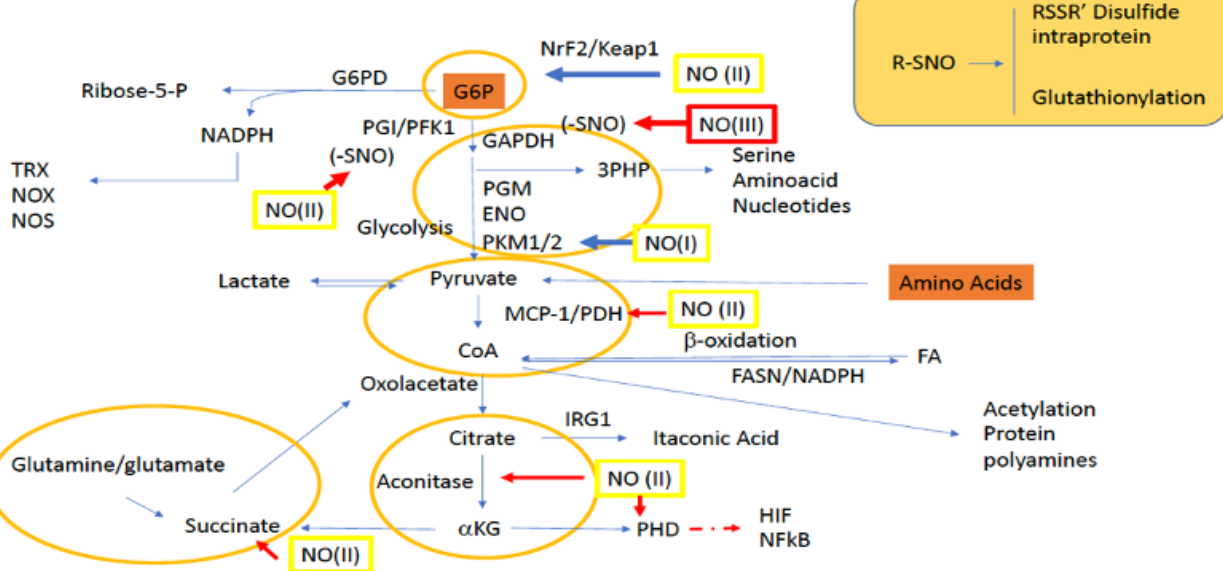
Figure 2. Sites for NO activity along glycolysis, the PPP, and the TCA. Green boxes/(II) represent intermediate levels of NO (nitrosative signaling) and red boxes/(III) indicate high levels of NO (nitrosative stress) required for NO interaction at the indicated site. Red arrows indicate inhibitory mechanisms while blue arrows indicate activating mechanisms.